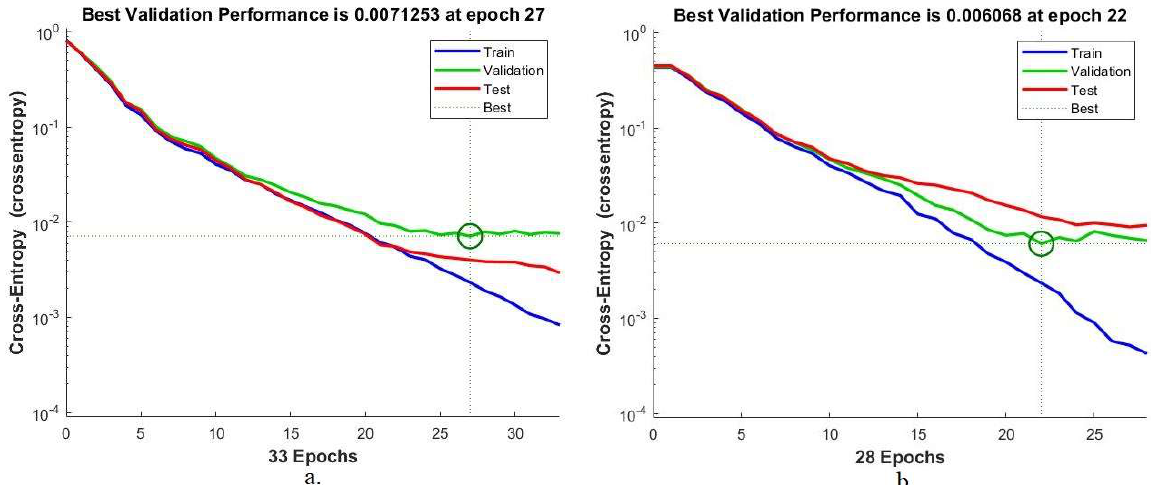
Figure 11. Best validation for evaluating ANN performance based on hybrid features. ( a ) AlexNet, DWT, LBP, FCH, and GLCM; ( b ) ResNet-18, DWT, LBP, FCH, and GLCM.